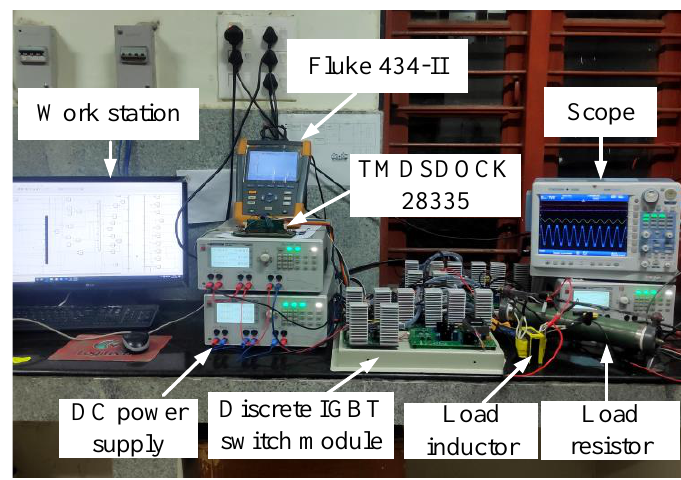
Figure 15. Experimental system. The output voltage waveforms for 3rd and 9th order harmonic elimination obtained from experimental hardware setup using both conventional and proposed techniques are shown in Figures 16 and 17.